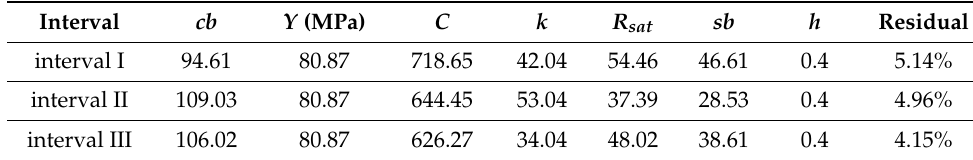
Table 3. Optimal parameters with VW-PSO.